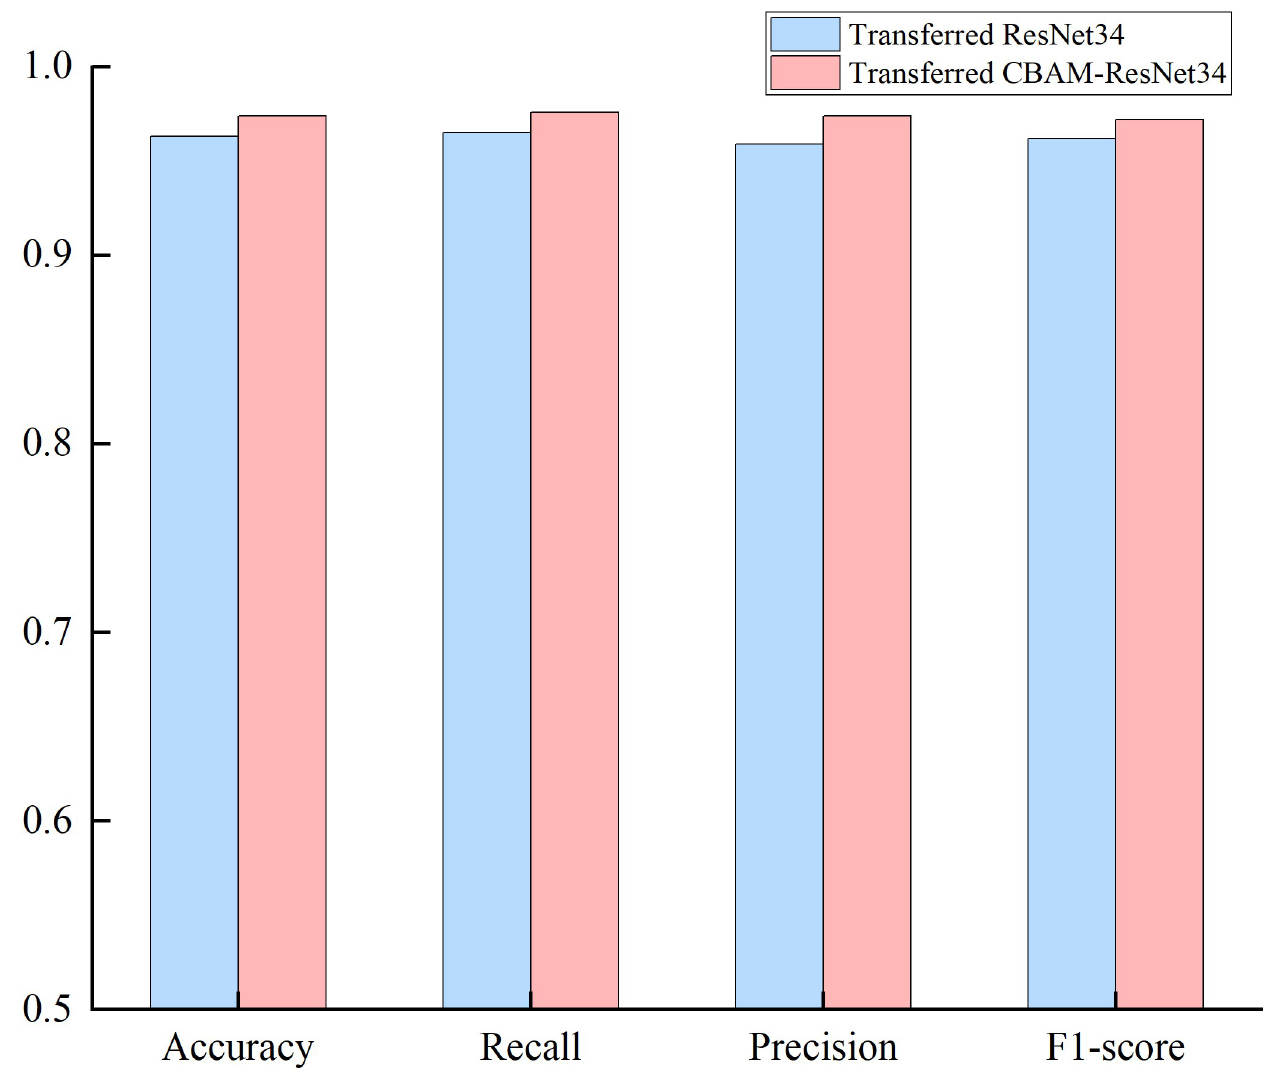
Fig 14. The evaluated metrics between transferred ResNet34 models with and without CBAM.